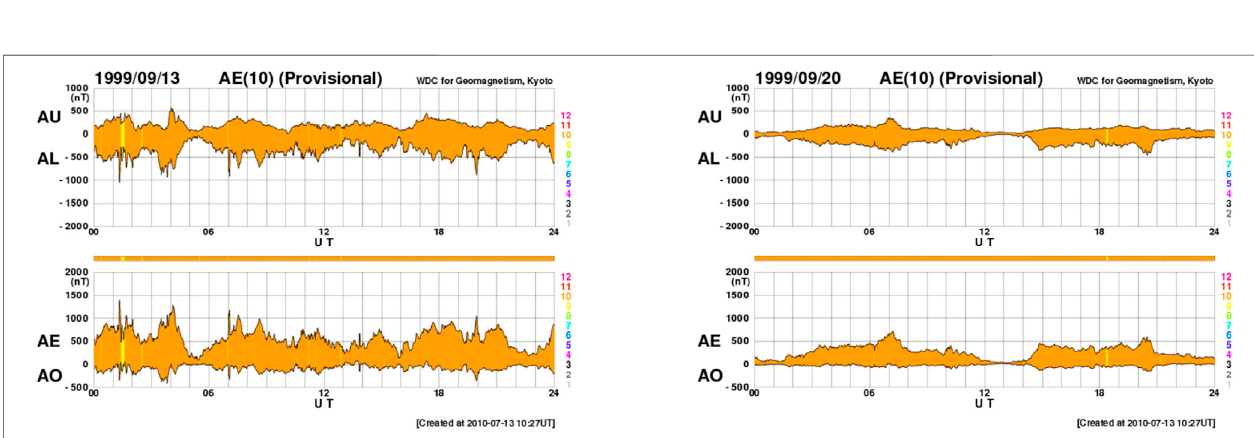
FIGURE3| AuroralElectrojetindexeson13.9.1999,thedayafterthestormonsetandduringadayatitsrecoveringphaseofthelonglastingstormoccurredbefore the Chi-Chi earthquake.